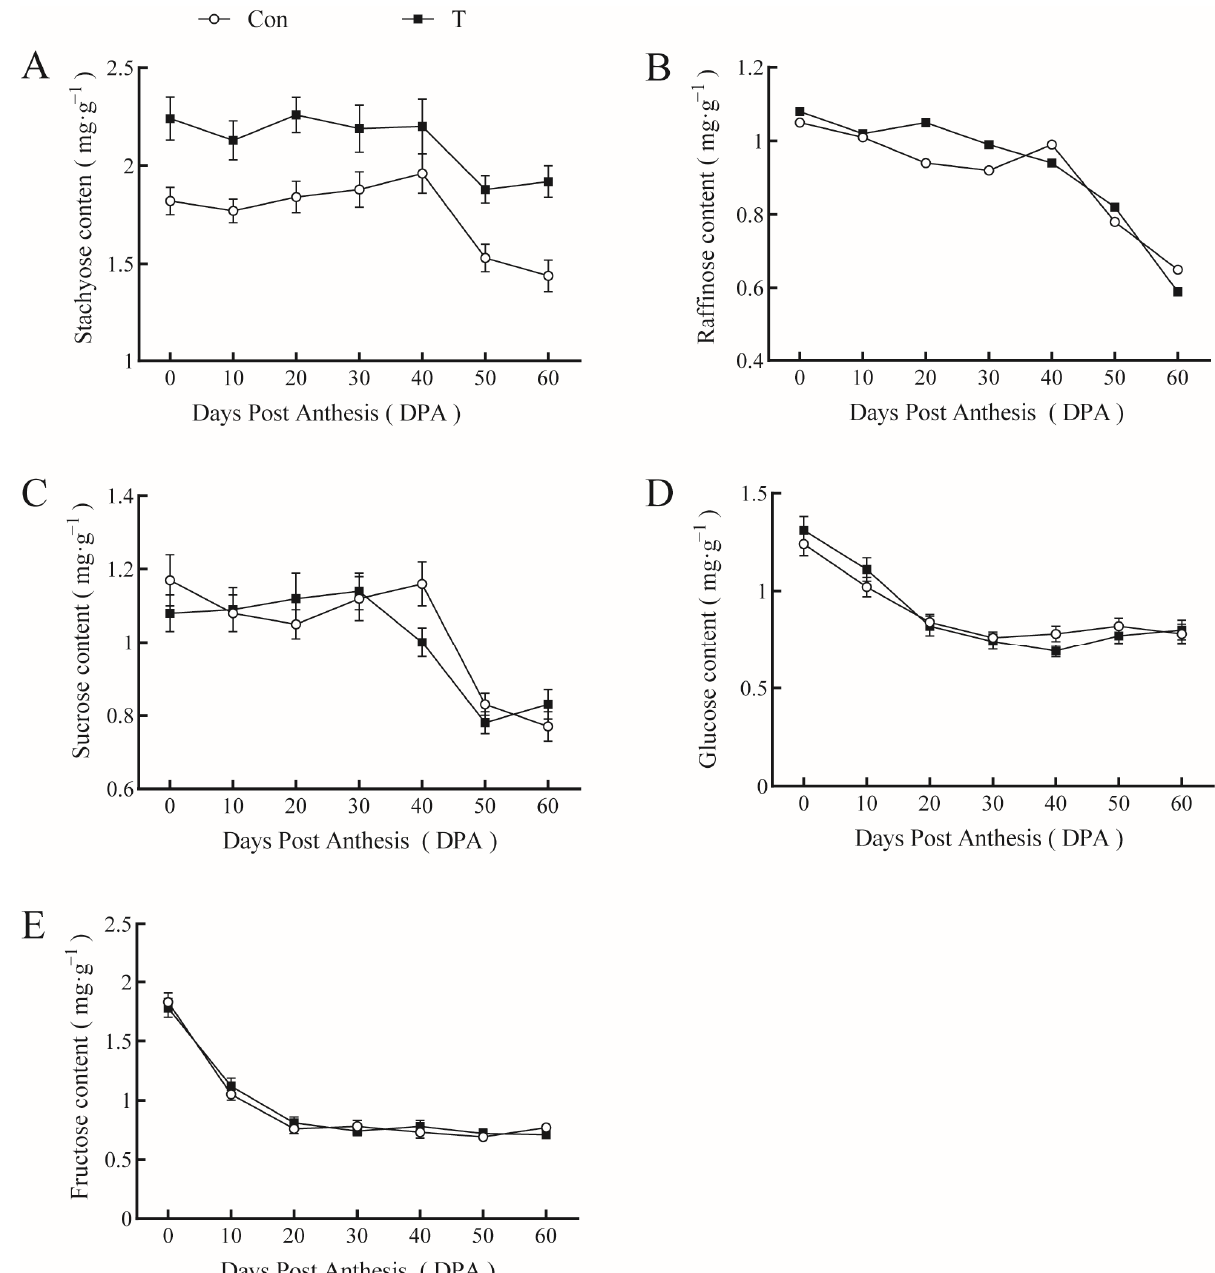
Figure 5. Effect of NAA and EBR on soluble sugar content in giant pumpkin leaves. ( A ) Stachyose, ( B ) raffinose, ( C ) sucrose, ( D ) glucose, ( E ) fructose. 2.5. Effects of NAA and EBR on Soluble Sugar Content in the Phloem Sap of Giant Pumpkin